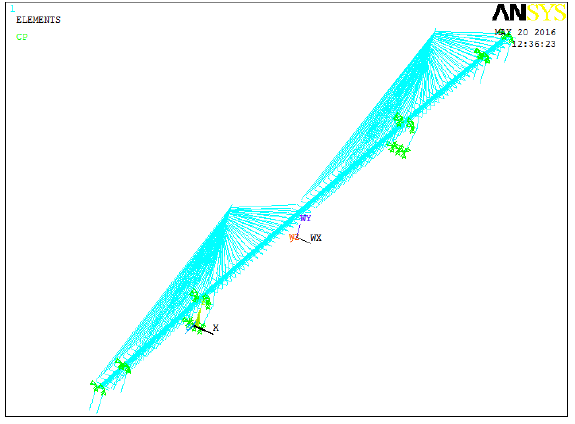
Figure 5. Finite element model of Xiangshan Harbor Bridge.